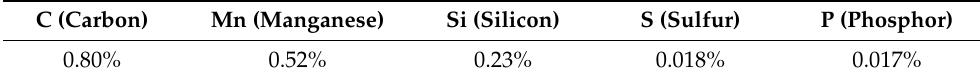
Table 1. Chemical composition of steel wires.